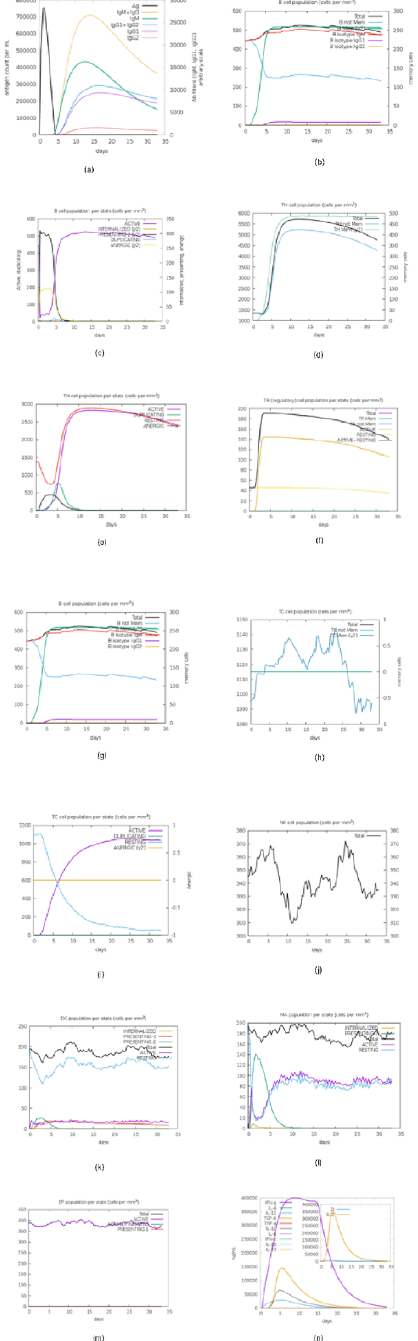
Figure 10. Immune simulation prediction: ( a ) Antigens and immunoglobulins. Antibodies are sub- divided per isotype. ( b ) Lymphocytes B total count memory cells. ( c ) B lymphocytes population per entity-state (i.e., showing counts for active, presenting on class-II, internalized the Ag, duplicating and anergic. ( d ) CD4 T-helper lymphocytes count. Total and memory counts were shown on the plot. ( e ) CD4 T-helper lymphocytes count sub-divided per entity-state (i.e., active, resting, anergic, and duplicating). ( f ) Plasma B lymphocytes count sub-divided per isotype ( g ) CD4 T-regulatory lymphocytes count. ( h ) CD8 T-cytotoxic lymphocytes count. Total and memory shown. ( i ) CD8 T- cytotoxic lymphocytes count per entity-state ( j ) Natural killer cells (total count). ( k ) Dendritic cells. ( l ) Macrophages. Total count, internalized, presenting on MHC class-II, active and resting macro- phages. ( m ) Epithelial cells. ( n ) Cytokines (concentration of cytokines and interleukins with D sig- nifying danger.